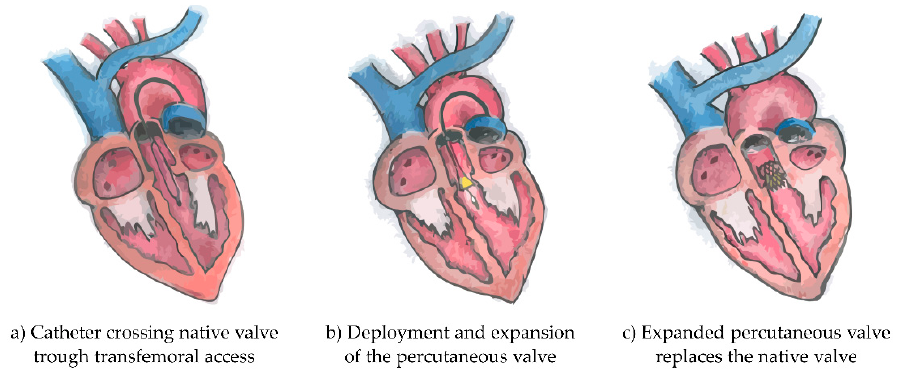
Figure 1. Diagrams of the three phases of transcatheter aortic valve implantation intervention. Originally the catheter crosses the native valve trough transfemoral access ( a ), follows the deployment and expansion of the percutaneous valve ( b ) and finally the expanded percutaneous valve replaces the native valve ( c ).